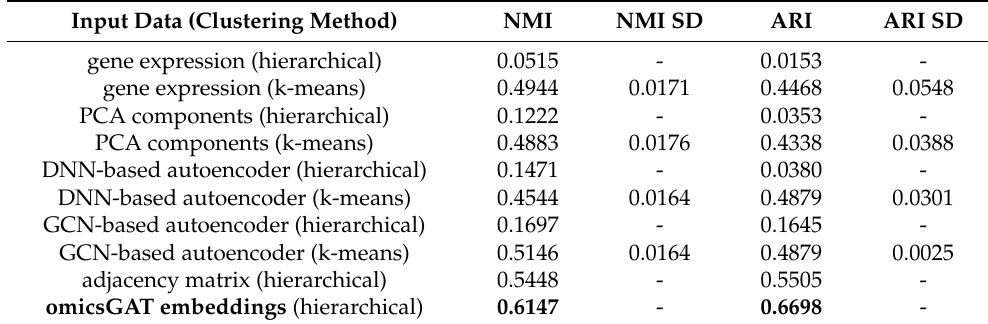
Table 3. The clustering performance on TCGA bladder cancer (BLCA) dataset. The NMI and ARI scores of omicsGAT Clustering and baseline methods are reported in the table. Hierarchical clustering was computed with ‘Manhattan’ distance and ‘Average’ linkage. Mean NMI and ARI scores with standard deviation (SD) are reported for k-means clustering (run 10 times).